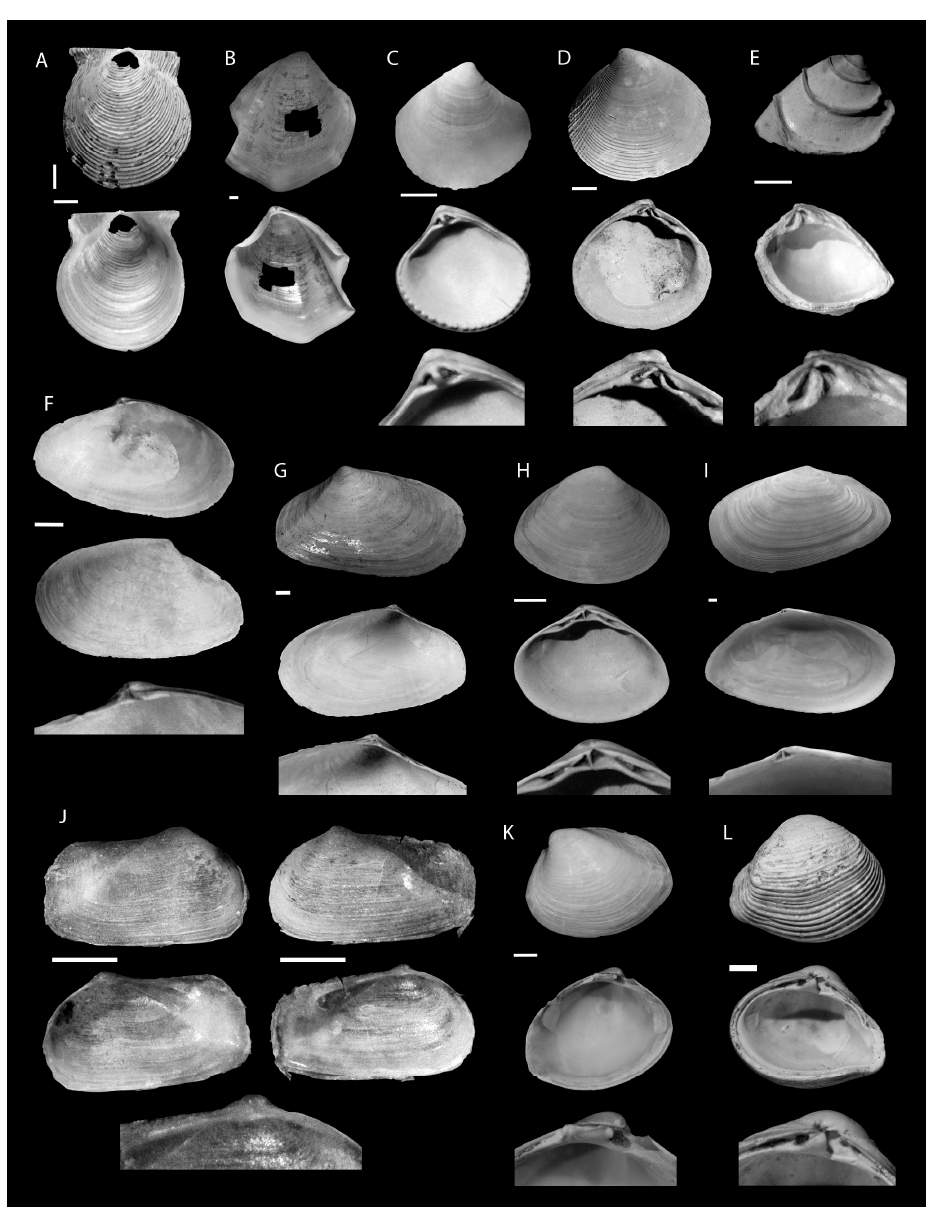
Figure 4. ( A ) Hyalopecten strigillatus ; ( B ) Thyasira trisinuata ; ( C ) Astarte sp.; ( D ). Microcardium sp.; ( E ) Chione sp.; ( F ) Macoploma exteuata ; ( G ) Macoploma tageliformis ; ( H ) Macoma sp.; ( I ). Eurytellina niten ; ( J ) Sphenia sp.; ( K ) Caryocorbula contracta ; ( L ) Caryocorbula dietziana . Scale bars = 1